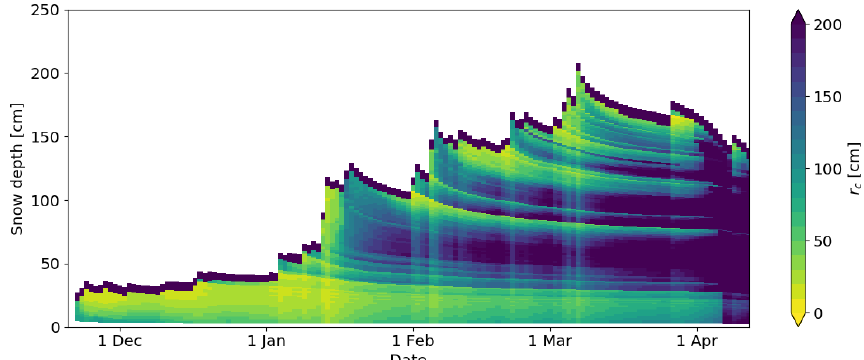
Figure 12. Temporal evolution of the vertical profile of the critical crack length modeled with SNOWPACK using Eq. (8) for WFJ 2015–